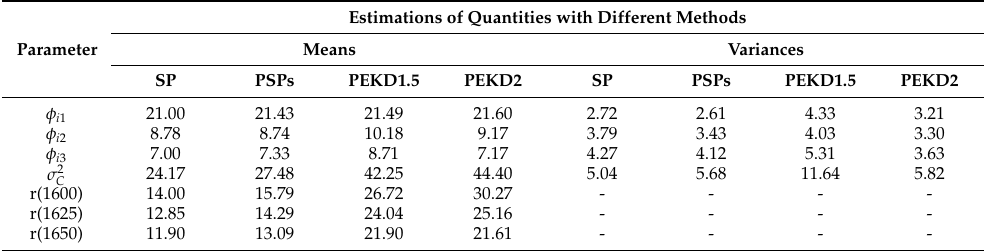
Table 1. The error ratios of thinning method over SP, PSP and PEKD methods in estimating the posterior quantities. The larger, the better. Estimations of Quantities with Different Methods Parameter